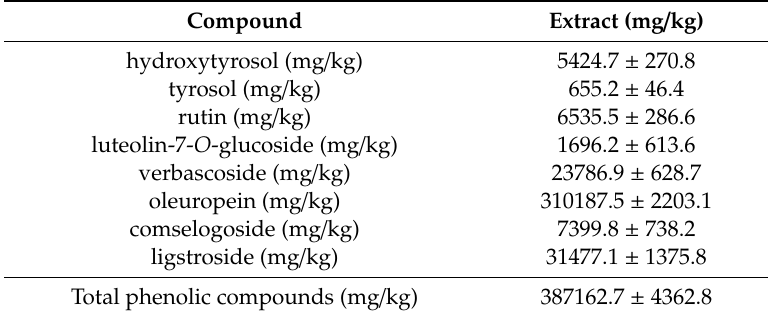
Table 1. Phenolic composition of the olive extract. Data are expressed as the mean ± SD from three independent